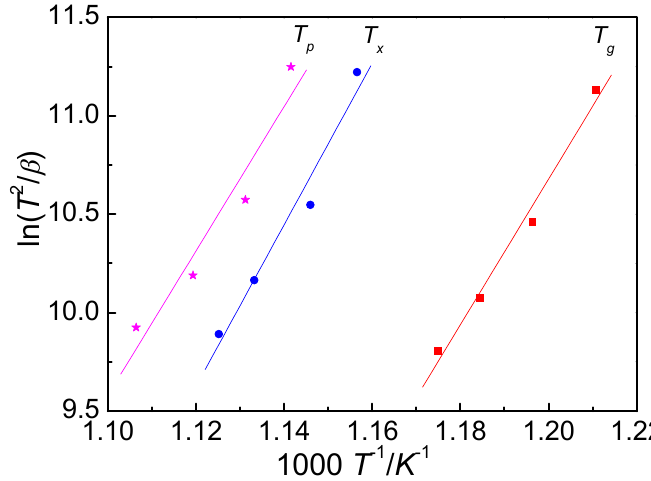
Figure 3. Kissinger plots of the Fe 68 Nb 6 B 23 Mo 3 glassy alloys.